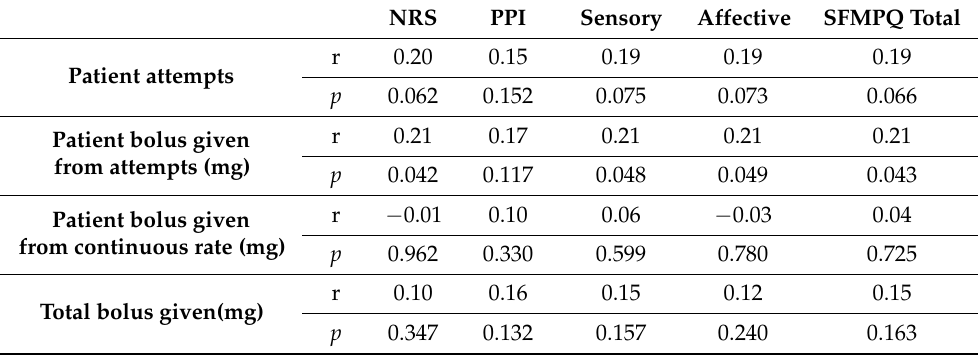
Table 4. Correlations between PCA pump amounts and average pain scores for each pain scale during the first 24 postoperative